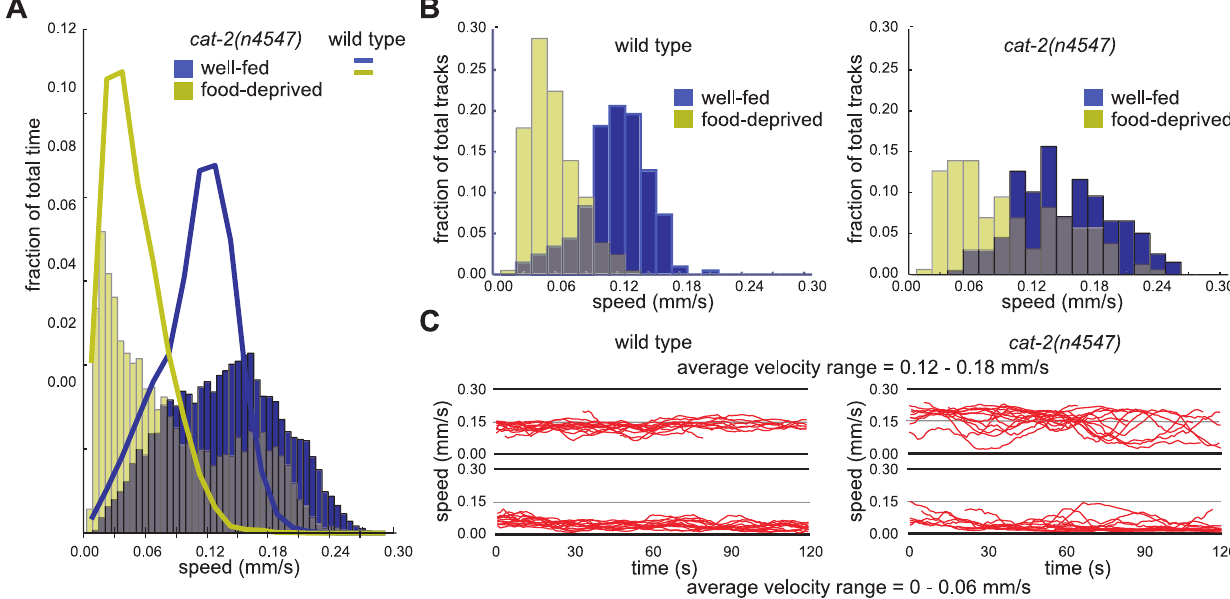
Figure 3. The locomotion rates of cat-2 mutants were more variable than those of wild-type animals. (A) Frequency distributions of instantaneous speed recordings of cat-2(n4547) mutants in each condition. Each bin is 0.006 mm/sec wide. Wild-type frequency distribution outlines are overlaid for comparison. The standard deviations of speed recordings in the well-fed and food-deprived conditions were 0.037 and 0.029 mm/sec for wild-type animals and 0.054 and 0.061 mm/sec for cat-2 mutants. (B) Frequency distributions of average speeds of individual animals in the well- fed on-bacteria and food-deprived on-bacteria conditions. Each bin is 0.015 mm/sec wide. The standard deviations of average speeds of individual animals in the well-fed and food-deprived conditions were 0.031 and 0.023 mm/sec for wild-type animals and 0.047 and 0.054 mm/sec for cat-2 mutants. (C) The 15 longest wild-type and cat-2(n4547) speed traces with average velocities of 0–0.06 mm/sec and 0.12–0.18 mm/sec overlaid. (A–B: wild-type n=204 well-fed on-bacteria, 201 food-deprived on-bacteria animal tracks; cat-2 n=198, 158, all tracks . 20